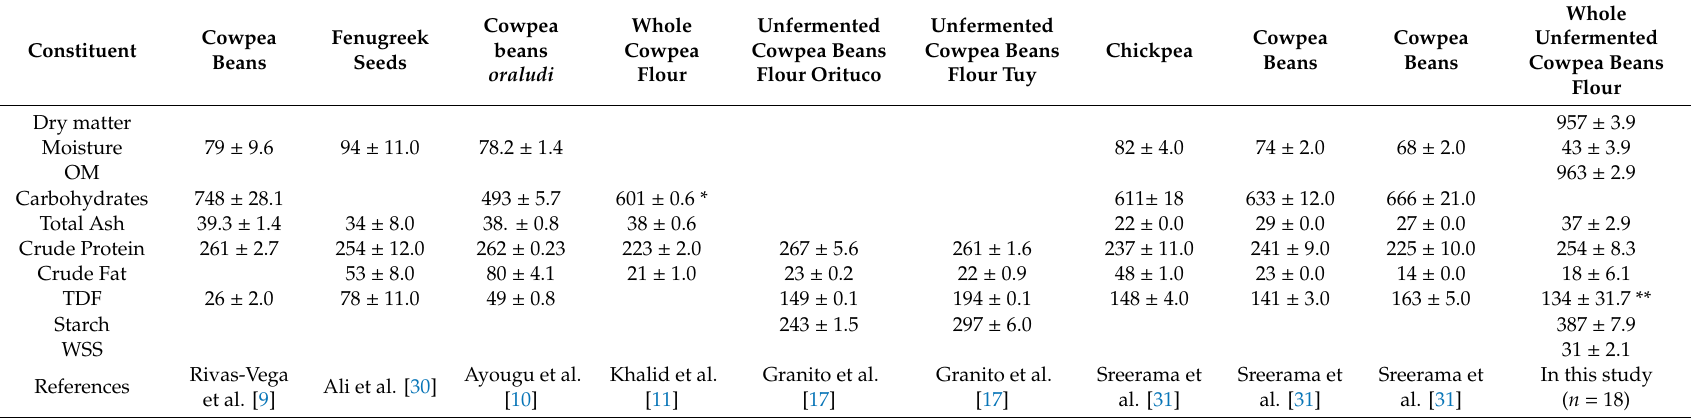
Table 1. Comparative analysis of the nutritional composition (g · kg − 1 DM) of cowpea beans and other similar legumes.